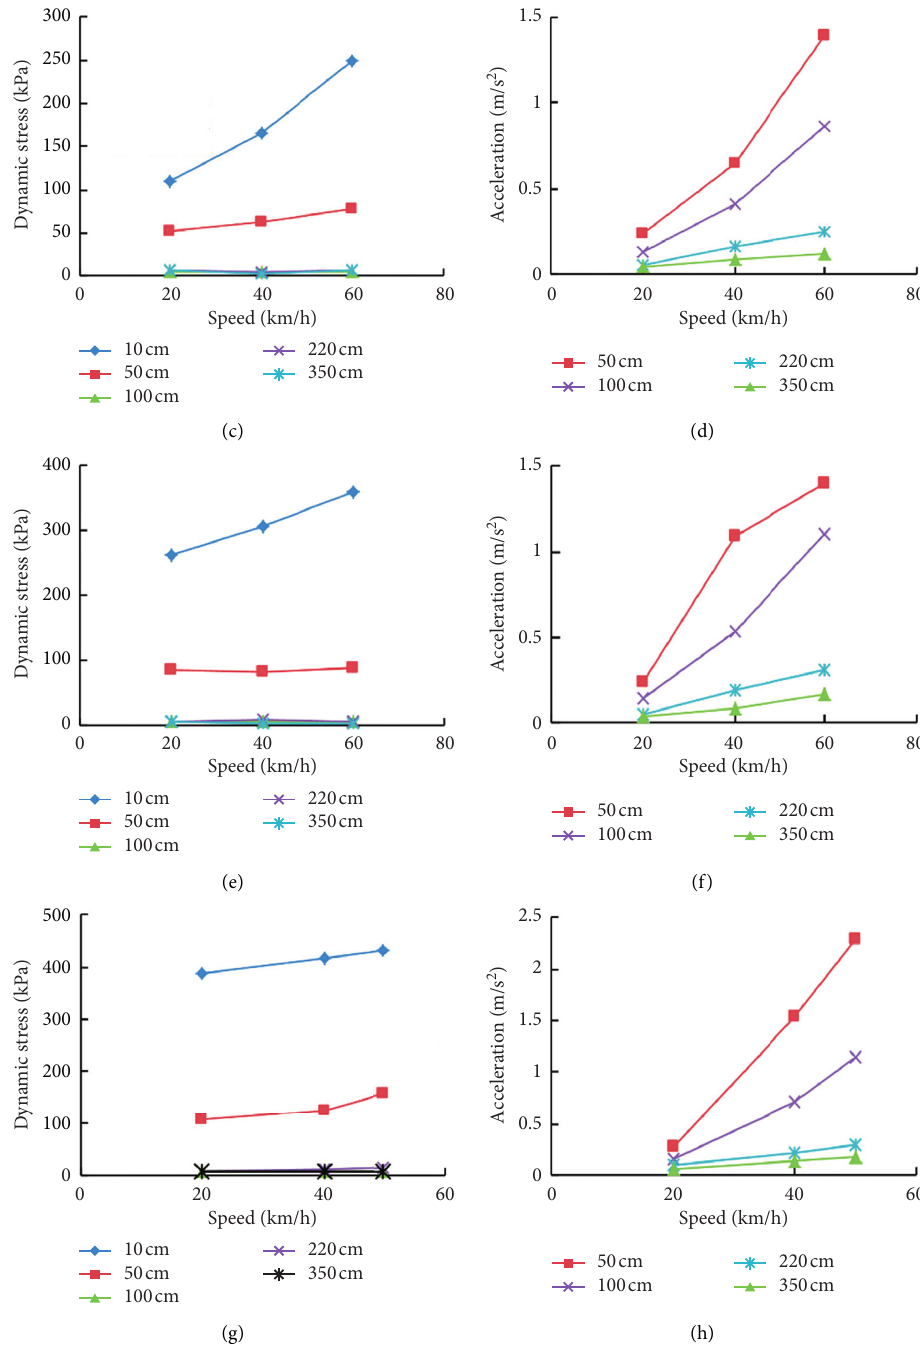
Figure 7: Development of peak dynamic stress and acceleration with vehicle speed under different axle loads: (a) dynamic stress of subgrade at 6t axial weight, (b) acceleration of subgrade at 6t axial weight, (c) dynamic stress of subgrade at 10 t axial weight, (d) acceleration of subgrade at 10t axial weight, (e) dynamic stress of subgrade at 15t axial weight, (f) acceleration of subgrade at 15 t axial weight, (g) dynamic stress of subgrade at 19t axial weight, and (h) acceleration of subgrade at 19t axial